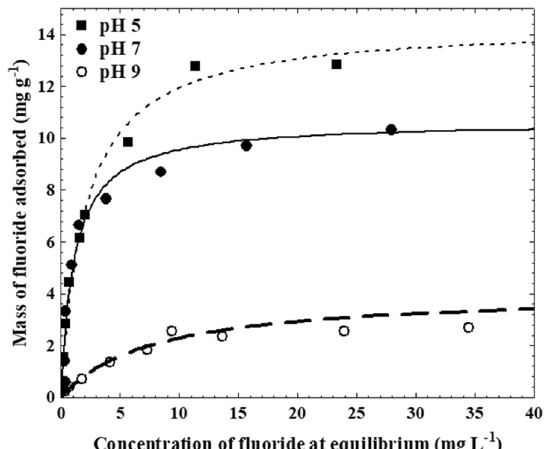
Fig. 9 Effect of solution pH upon the adsorption capacity of BCM2 towards fluoride from aqueous solution at T represent the Langmuir isotherm prediction